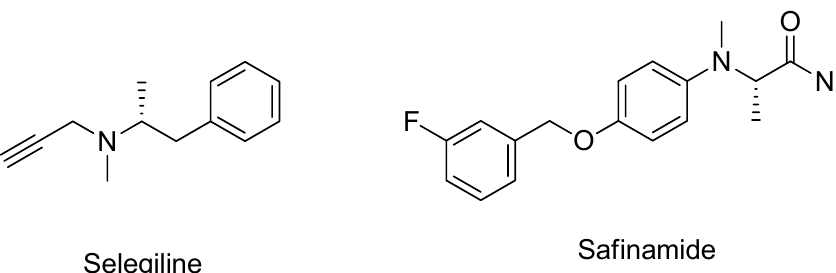
Figure 14. Structures of the clinically approved MAO-B inhibitors.